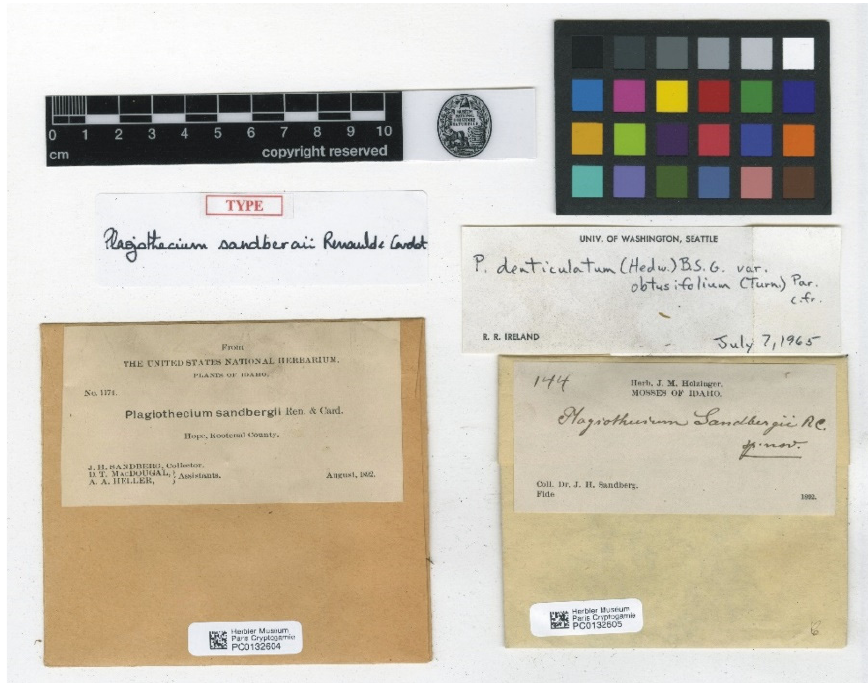
Figure 7. Types of P . sandbergii (PC0132604, PC0132605), from the herbarium PC website (https://science.mnhn.fr), downloaded 15 April 2022.